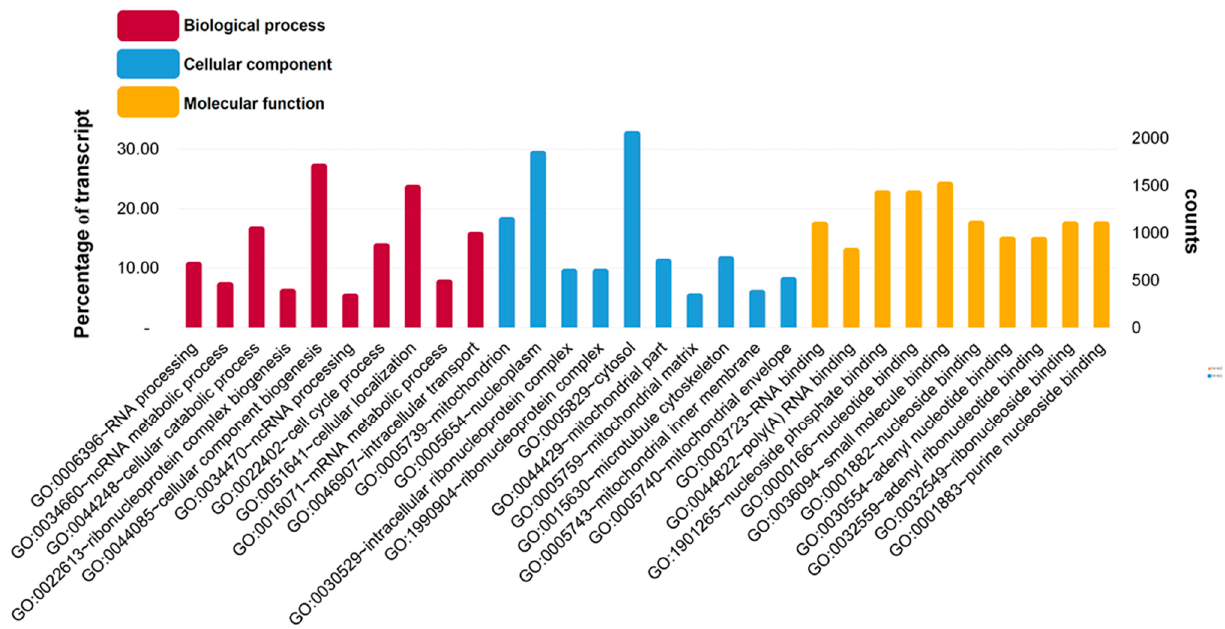
Figure 3. GO functional classification assigned the most percentage of the annotated transcripts to cellular component biogenesis term for biological process; cytosol term for cellular component; and small molecule binding term for molecular function, respectively. Analysis was carried out with the WEGO program for the edible sea urchin ( L. albus ) reference transcriptome.